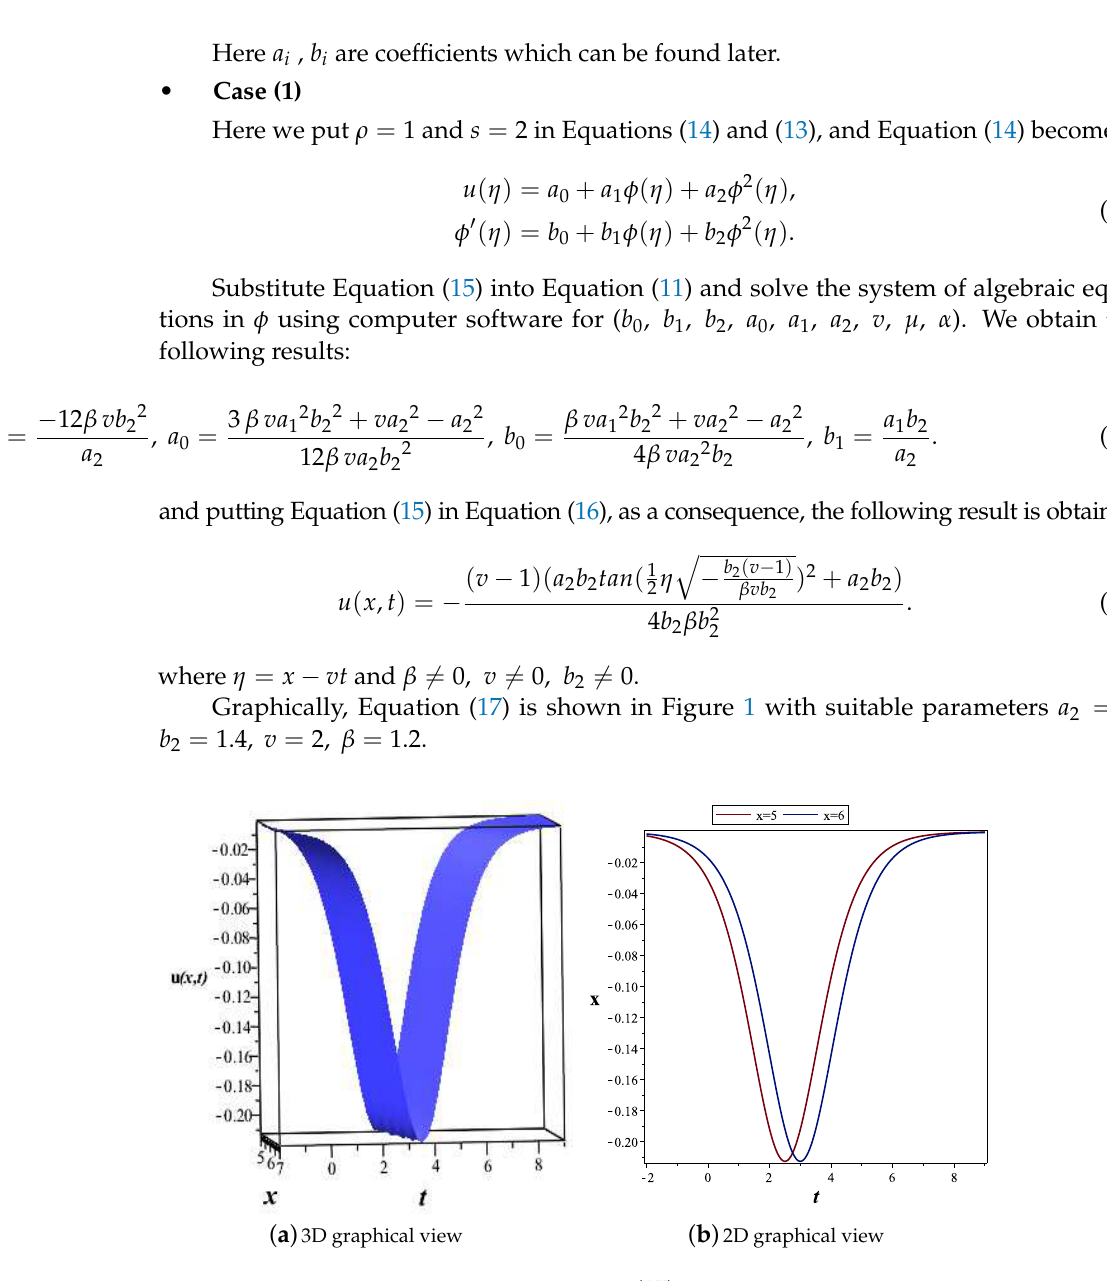
Figure 1. Graphical representation of Equation (17) within interval 5 ≤ x ≤ 7 and − 2 ≤ t ≤ 9 (the ( b ) shows 2D plot for x = 5,